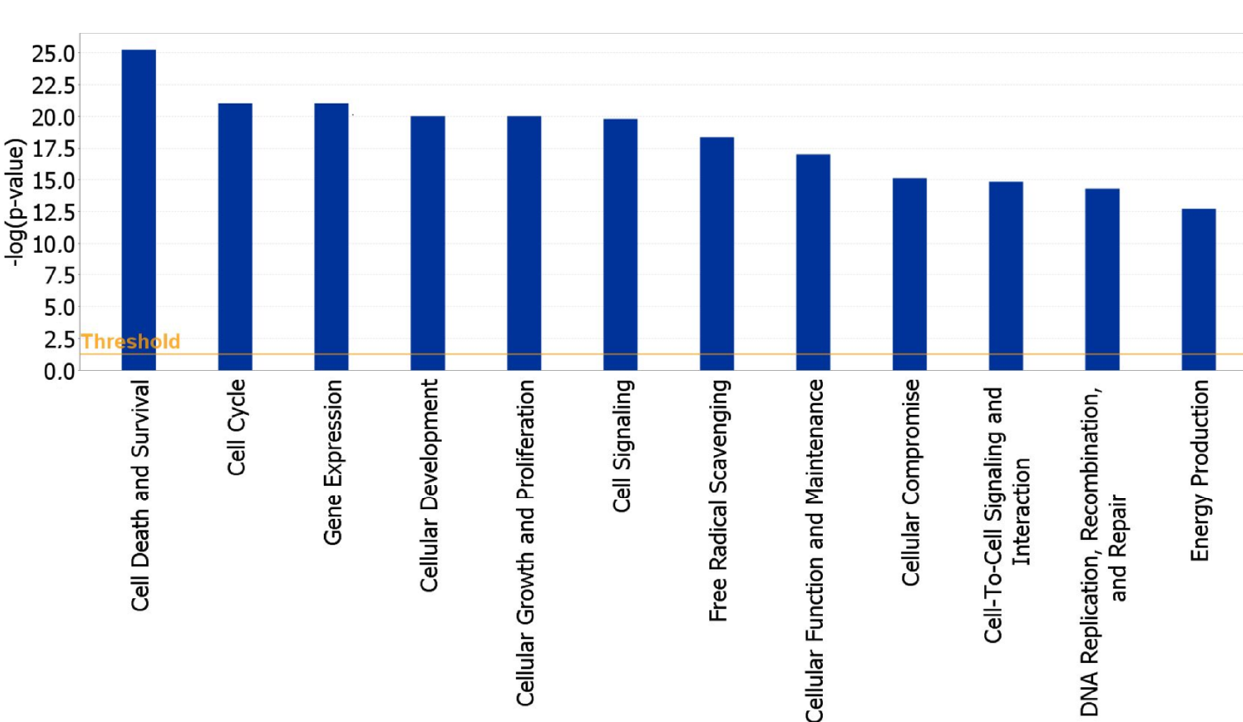
Table 2 . List of under- and over-expressed genes following exposure to cigarette smoke in cumulus cells of smokers compared to controls, type(s) and cell location.